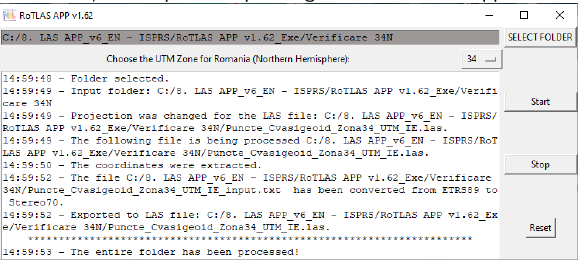
Figure 6 . The graphic interface of RoTLAS APP